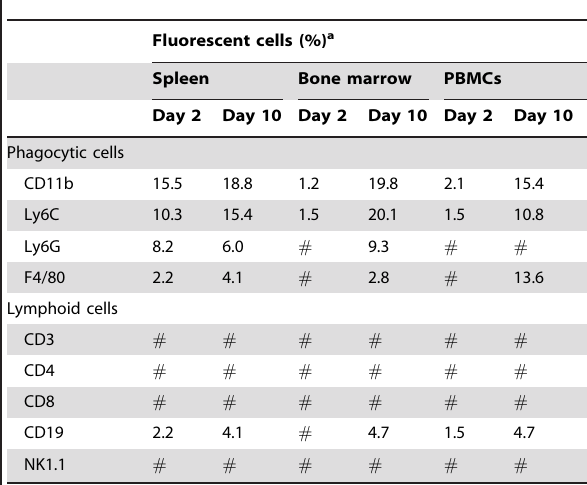
a The ( # ) symbol indicates , 1% fluorescent cells.